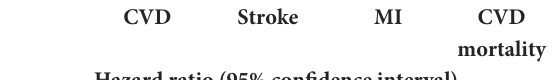
TABLE 2 Association of cumulative or baseline blood pressure levels (continuous scale) with hazards of cardiovascular disease (per 1 standard